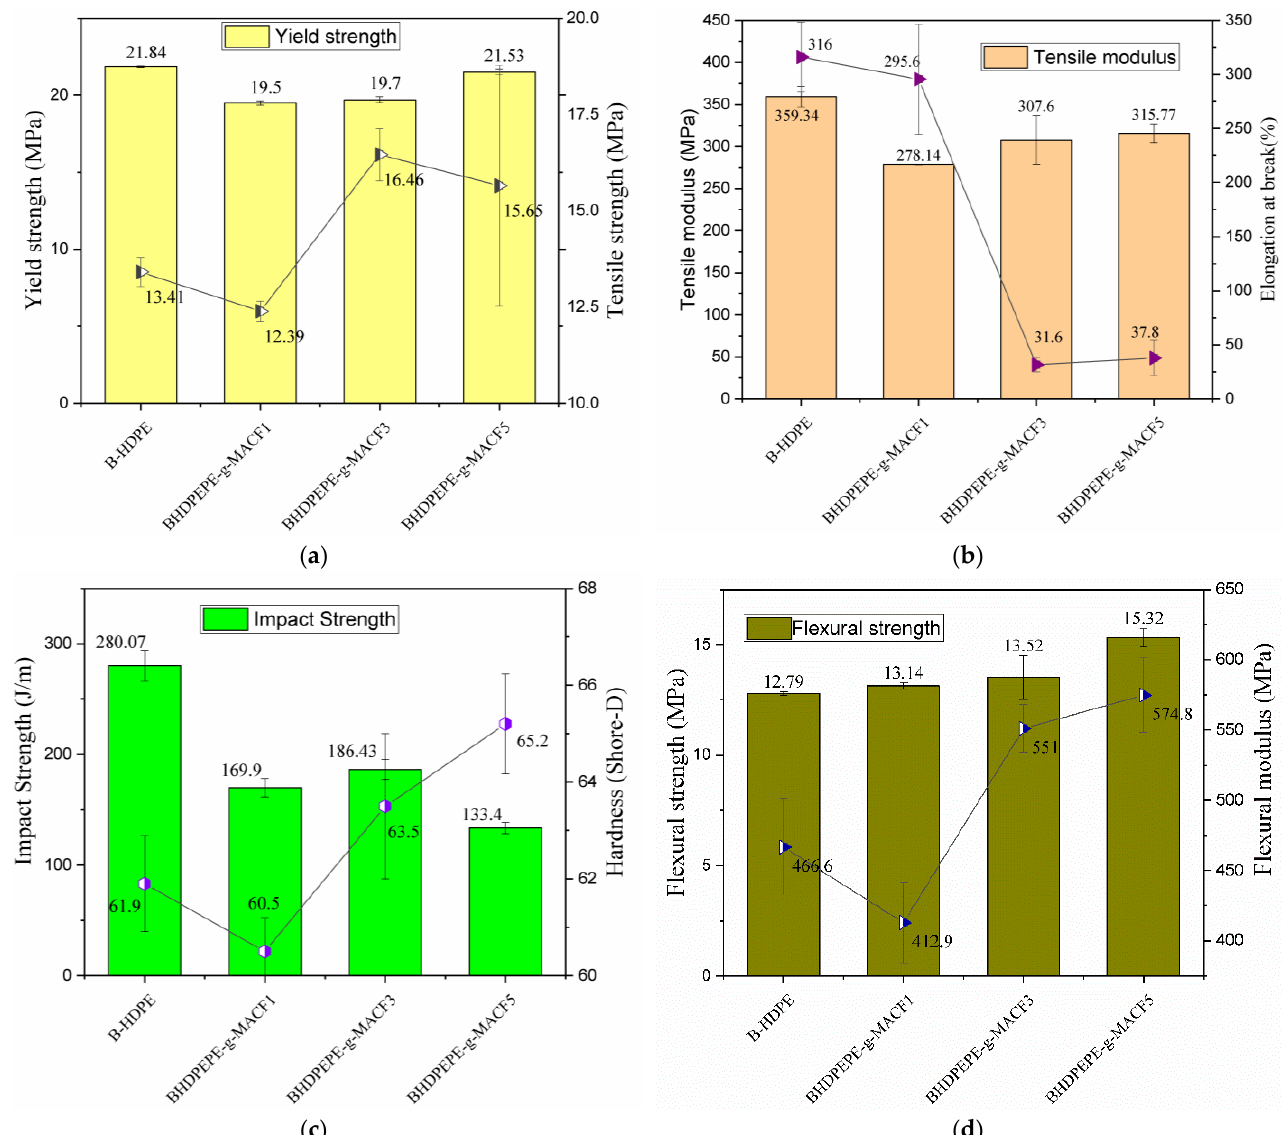
Figure 9. Mechanical properties of B-HDPE and biocomposites: ( a ) yield strength and rupture stress; ( b ) modulus under tension and deformation until failure; ( c ) impact strength and hardness; ( d ) flexural strength and flexural modulus.